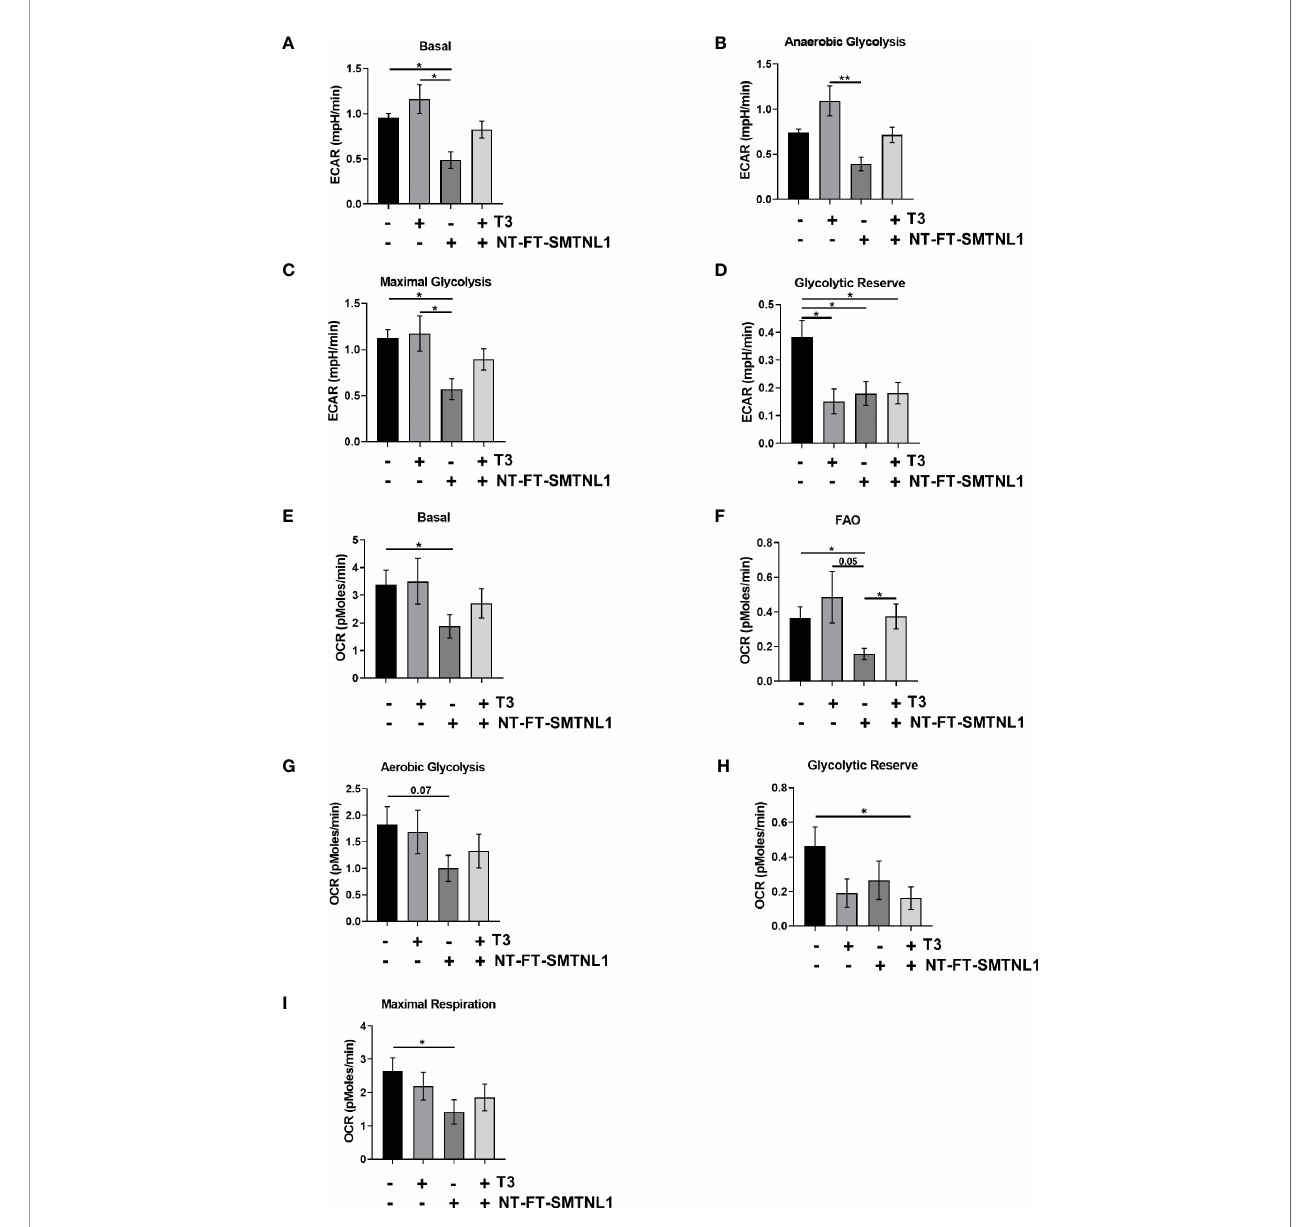
FIGURE 9 | Measurement of Extracellular Acidi fi cation Rate (ECAR) and Oxygen Consumption Rate (OCR) by SeaHorse Analysis of C2C12 Myoblasts. (A – I) Following a 72-hour T3 treatment of empty vector or NT-FT-SMTNL1-transfected myoblasts, XF assay media supplemented with glucose was added to the cells. Myoblasts and the previously hydrated XF sensor cartridge loaded with inhibitors, etomoxir (50 µM), oligomycin (2 µM), FCCP (4 µM) and antimycin (10 µM) + 2-deoxy-D-glucose (100 mM), were incubated in a non-CO 2 incubator before the assay. The rate of proton concentration increase (A – D) and the rate of oxygen concentration decrease (E – I) were measured. Values represent 4 groups with 23 technical replicates/group, n=2, mean +/- SEM. Data were normalized to protein content. Groups were compared using One-way ANOVA and Tukey ’ s post hoc test, p < 0.05 (*), p < 0.01